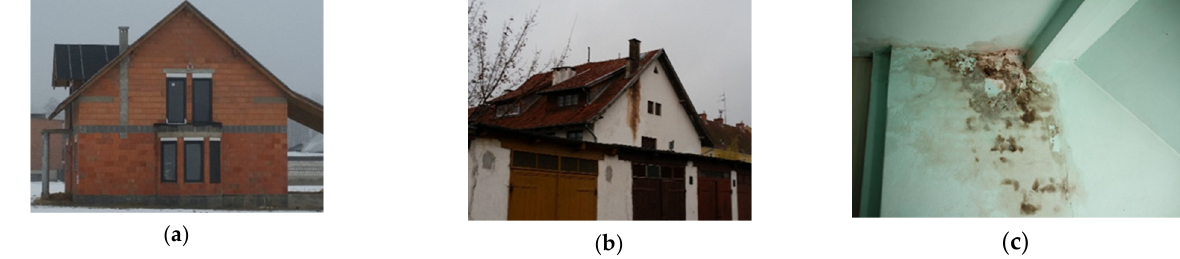
Figure 4. Non-thermally insulated chimney flues: ( a ) in the part above the roof, ( b , c ) in the attic space. These chimneys, both in the attic space and above the roof, do not have layers pro- tecting against excessive heat loss, and they cool down quite quickly. This is one of the